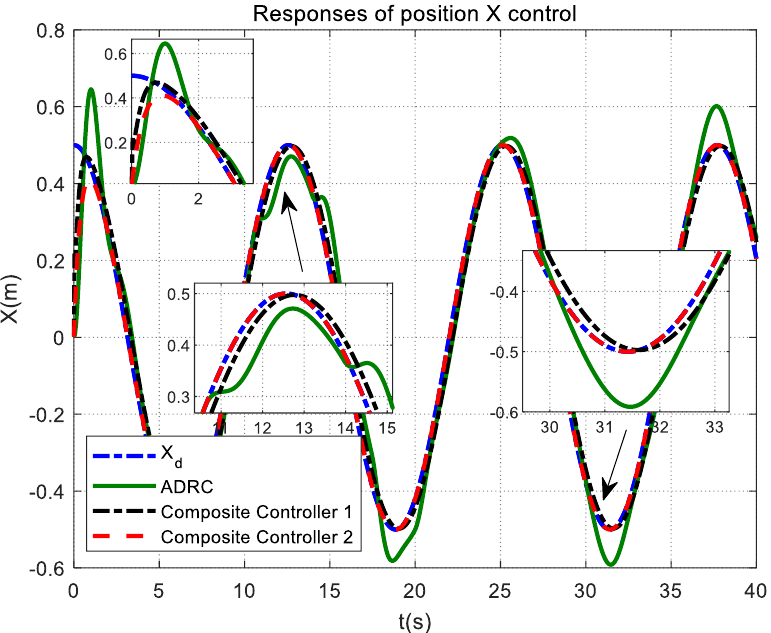
Figure 17. Responses of position X control for QUAV under actuator time‑varying fault and disturbance condition.